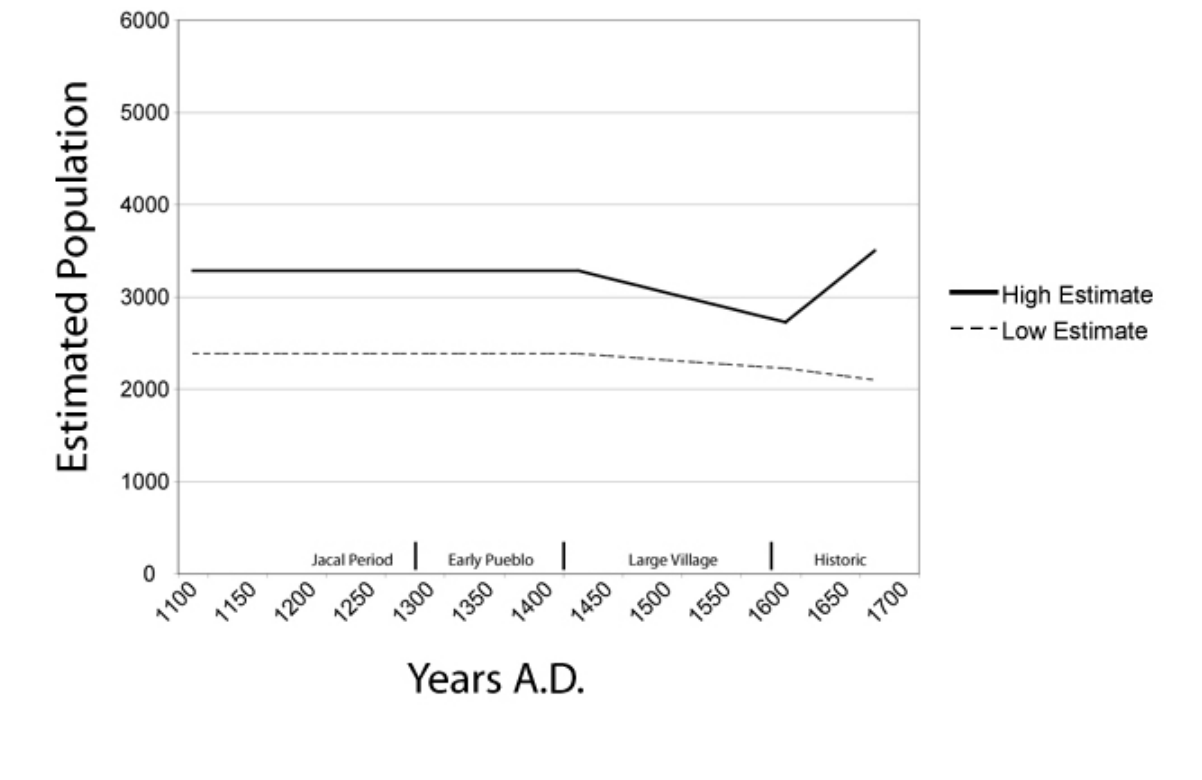
Fig. 7 . Population trends in the Salinas area. Source: Peeples 2009, unpublished manuscript